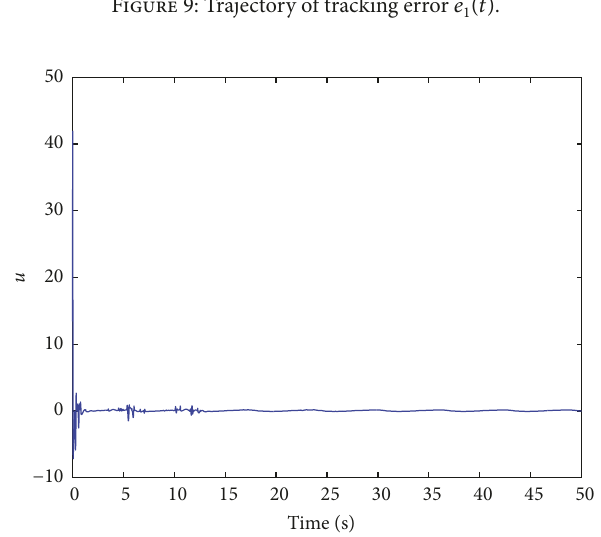
Figure 10: Trajectory of control input signal 𝑢(𝑡)